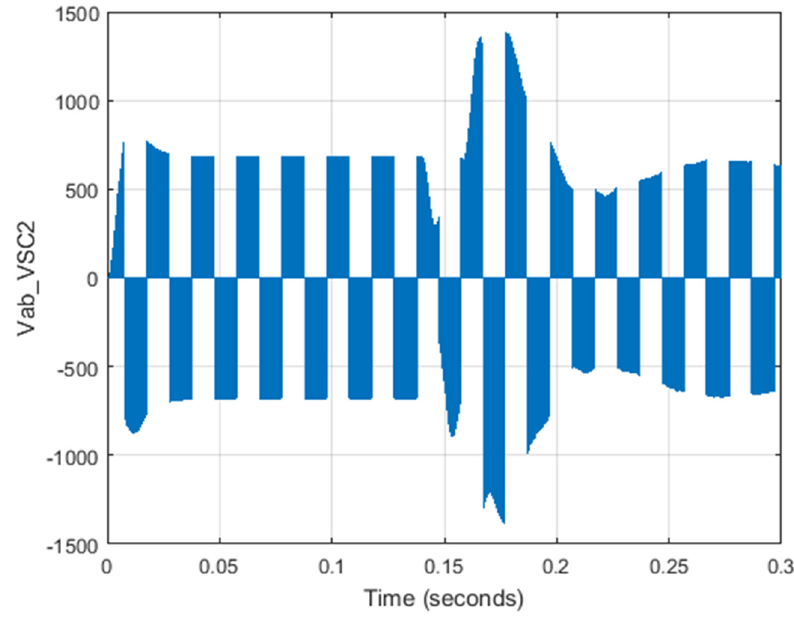
Figure 17. Two-phase voltage ab for VSC-2.